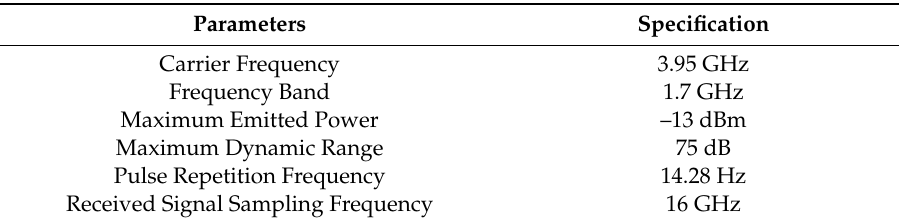
Table 2. Radar system